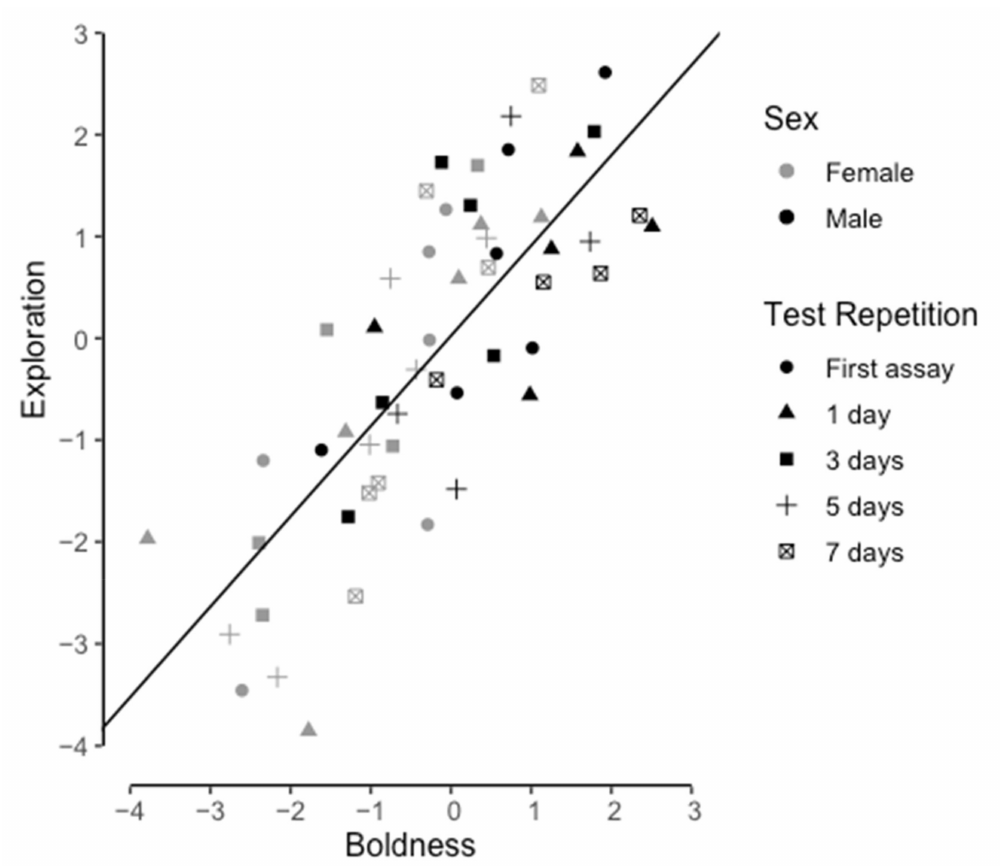
Figure 4. Positive correlation (correlation coefficient r = 0.809) between PCA values from Boldness and Exploration